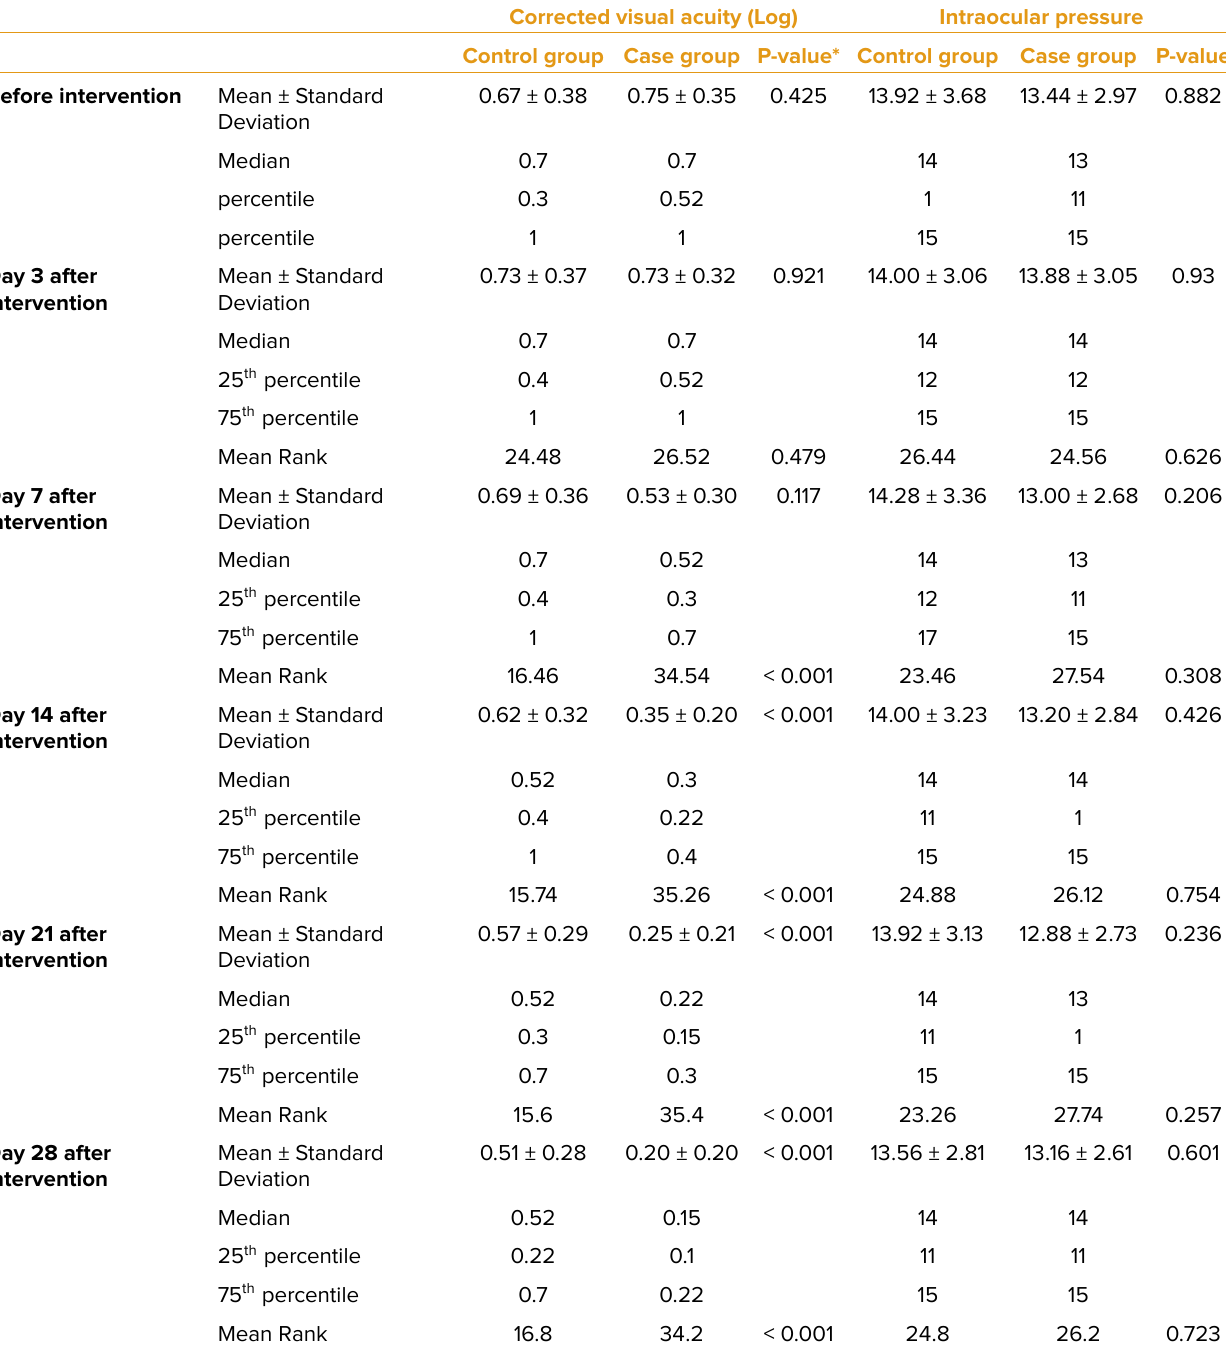
Table 2. Comparison of the best corrected visual acuity and intraocular pressure at the baseline, 3, 7, 14, 21, and 28 days after the intervention between the